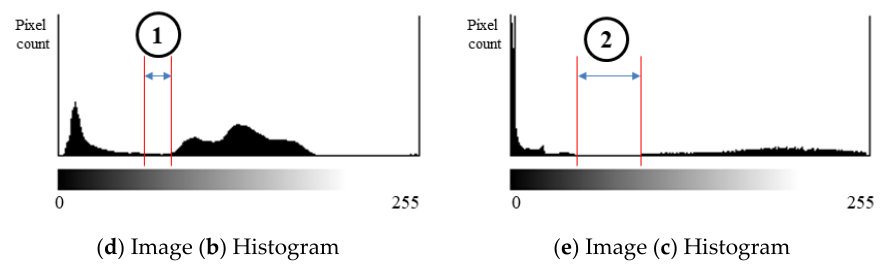
Figure 5. Comparison of a likelihood-based color model image with a gray-scale color model image.